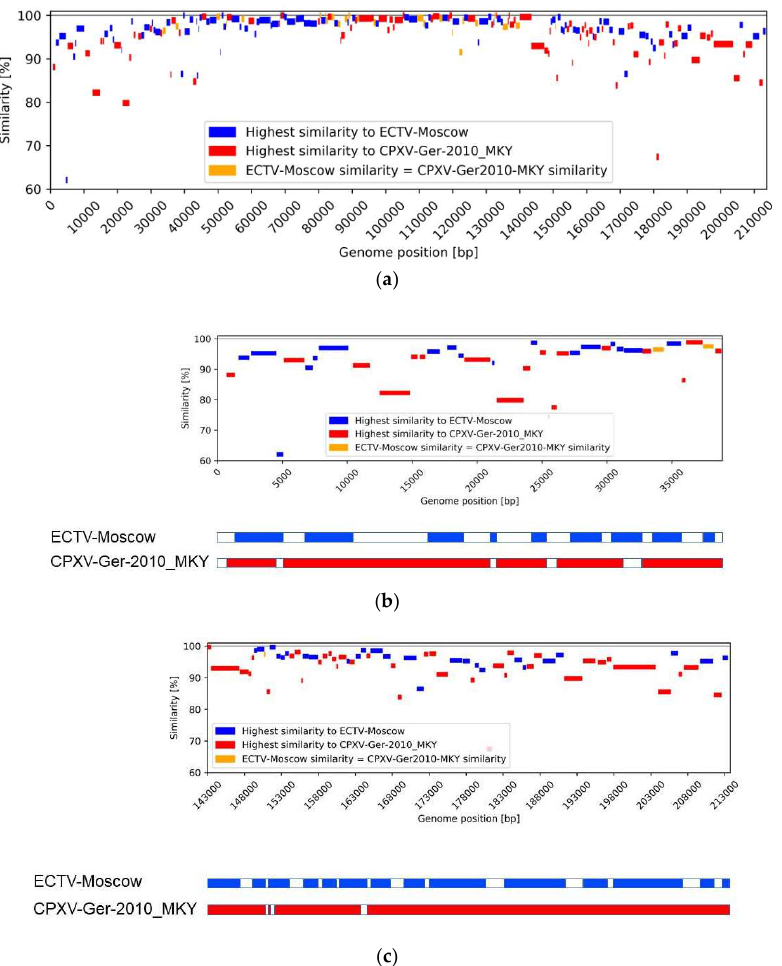
Figure 2. CDS similarity and gene synteny of OPV Abatino along their nt position, compared with the two most phylogenetically related OPV strains (Ectromelia virus-Moscow (ECTV-Mos) and CPXV-Ger2010-MKY). The CDS blocks are color coded: blue blocks represent the CDS with higher similarity to ECTV; red blocks represent CDS with higher similarity to CPXV; orange blocks represent CDS with comparable similarity to both reference genomes. ( a ) Similarity plot of the all CDS of OPV Abatino. ( b ) Similarity plot of left terminal region. ( c ) Similarity plot of right terminal region of the OPV Abatino genome. Bars below the plots show as empty boxes the regions of either ECTV-Mos or CPXV-Ger2010-MKY genome lacking homologous CDS in OPV Abatino. These 23 OPV Abatino CDS were compared by BLASTn to all OPVs used for the phylogenetic analysis, to identify the OPV genome with the highest identity. The results, shown in Table 1, indicate that the OPV genome with highest identity differed, depending on individual CDS, with identity range between 93.46% and 99.33%. In particular, 18 CDS showed their highest identity with various CPXV strains, and three showed highest identity with the VR-1431 strain of ECTV. For the remaining two genes, one showed highest identity with the VACV (Copenhagen strain) and one with the MPXV